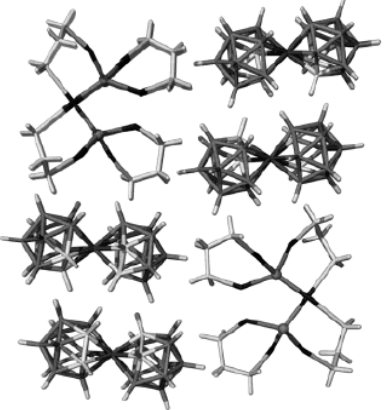
Figure 104. Crystal packing in structure of {[Ag(NC(CH 2 ) 3 CN) 2 ][3,3’-Co(1,2-C 2 B 9 H 11 ) 2 ]} n . Reprinted